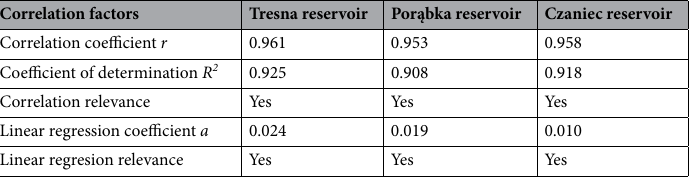
Table 3. Correlation analysis between pH and oxygen saturation for the water of the Soła cascade in 2019.